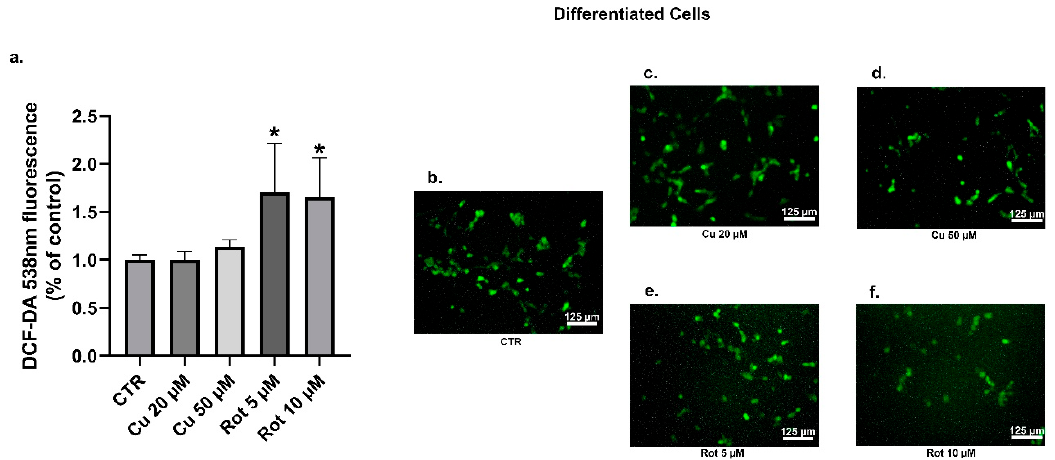
Figure 11. Differentiated SHSY5Y cells DCFDA analysis. The relative intensity of DCF was employed to evaluate the ROS levels. Cells were treated with 20 or 50 µ M copper ( c , d ) or 5 or 10 µ M rotenone ( e , f ) and compared to untreated cells ( b ). Fluorescence values were normalized on total protein ( a ). Values were compared with untreated cells (CTR) by one-way ANOVA following Tukey test * p < 0.0332.